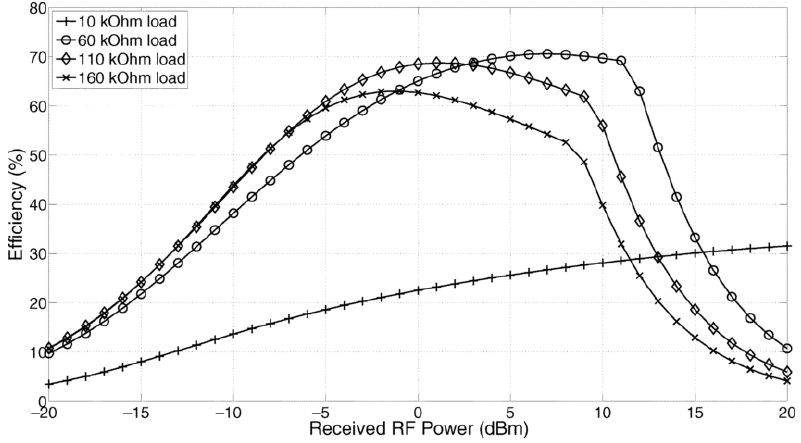
Figure 3. Power conversion efficiency vs. received RF power against different